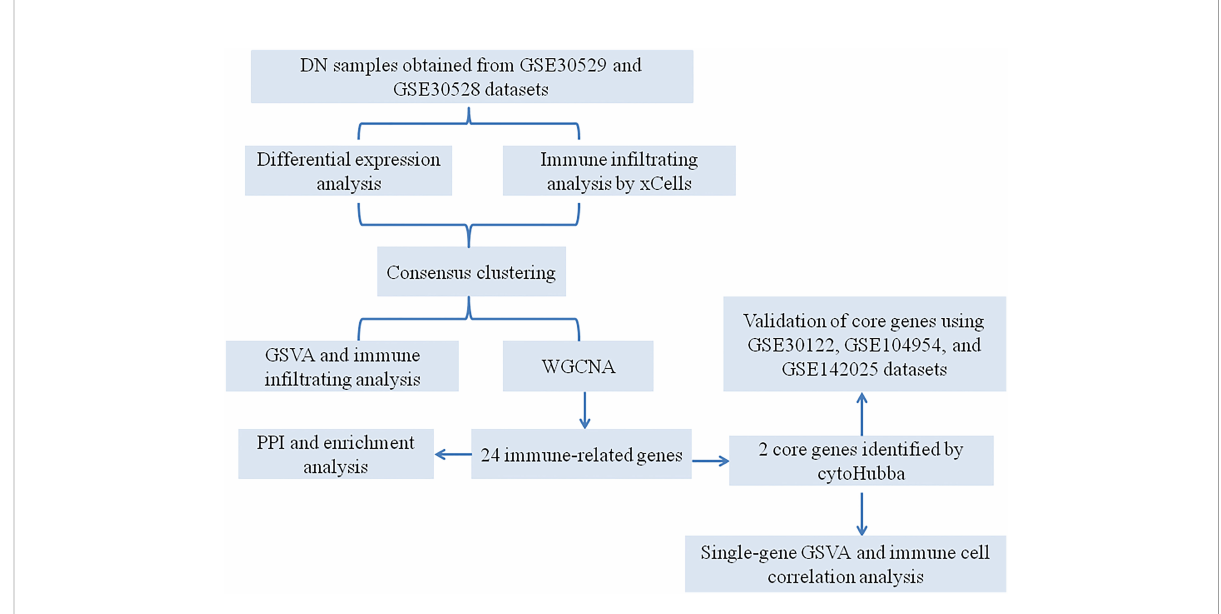
FIGURE 1 A fl owchart for the analysis process to identify potential genes and molecular subgroups in this